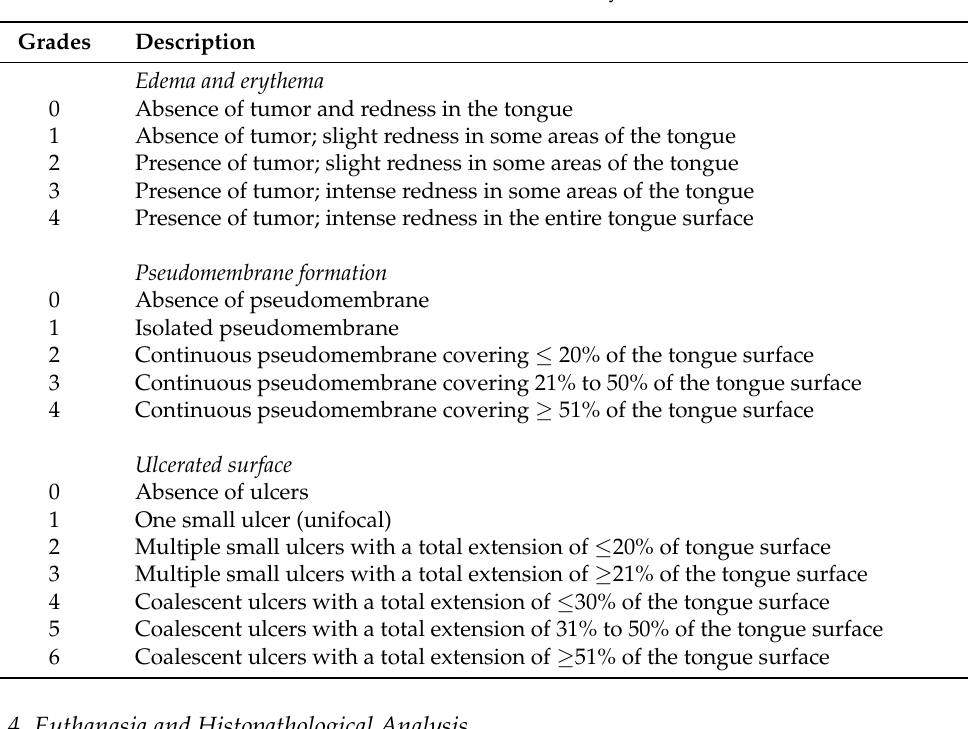
Table 2. Clinical scores for assessment of oral mucositis